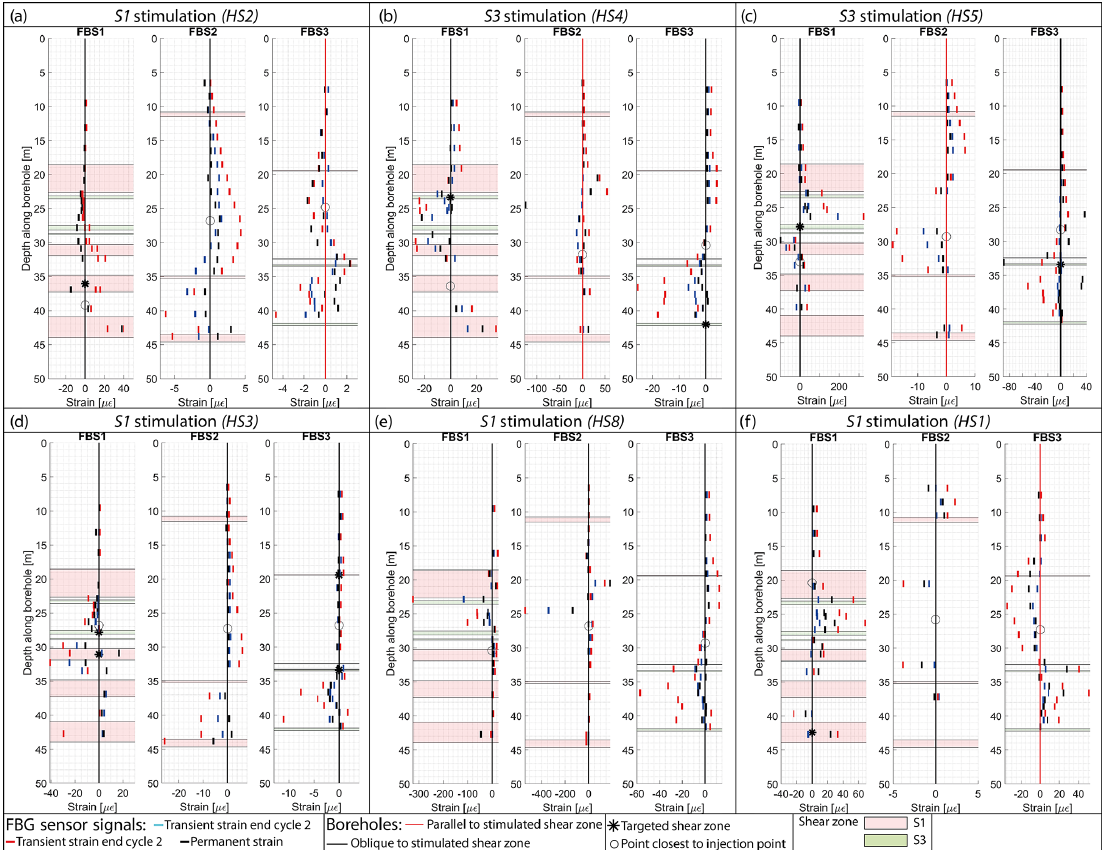
Figure A7. Strain along borehole axis picked as transient at the end of injection cycles 2 and 3, as well as the permanent strain signal after the